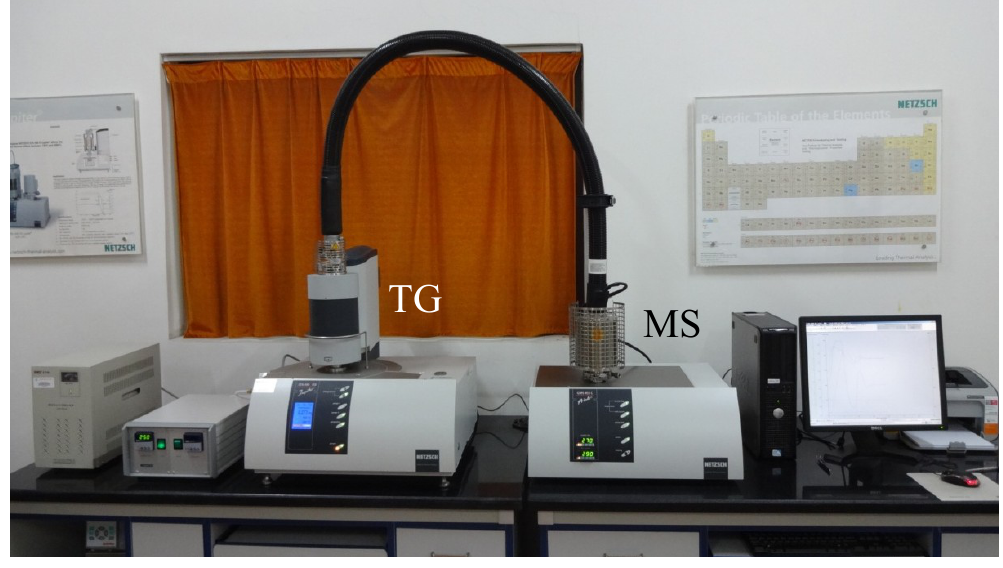
Figure 2. The TG-MS instrument used for characterizing volatile organic compound (VOC)